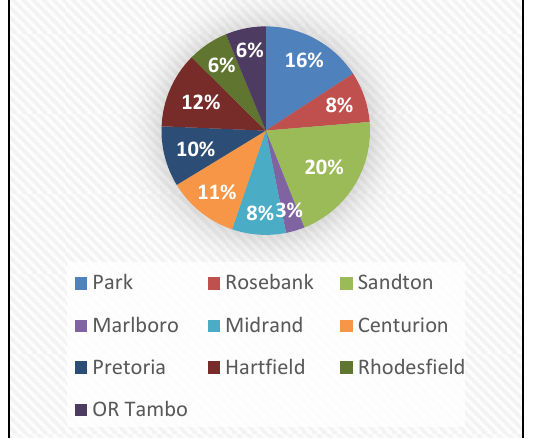
Figure 2: Number of passengers entering the station per month for January to June 2015